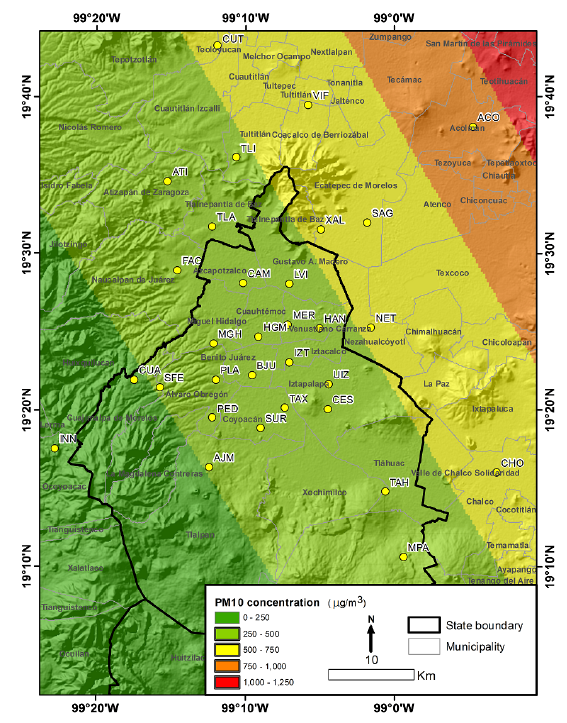
Figure 6. Return level surface for a return period of 25 years for the study